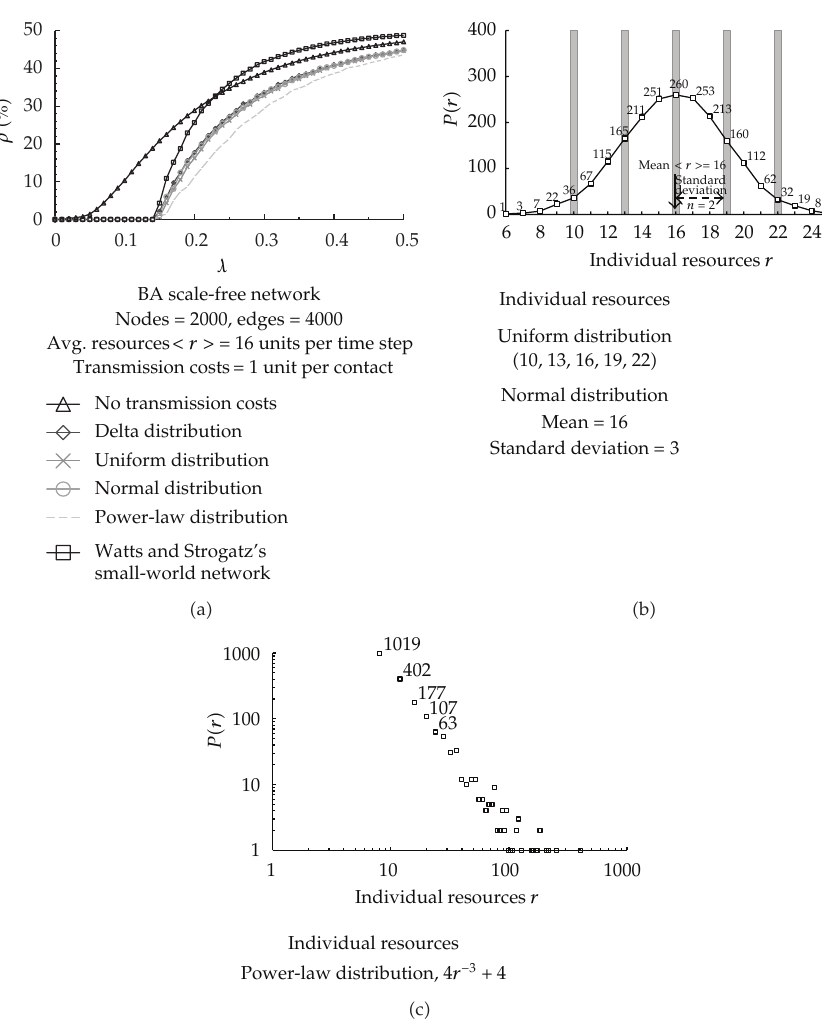
Figure 7: Simulation results for Scale-free network #3. (cid:3) a (cid:4) E ff ects of di ff erent statistical distribution types for agent resources on the density curves and epidemic tipping points of computer viruses spread within scale-free networks. (cid:3) b (cid:4) Uniform (cid:3) n (cid:7) 5, r (cid:7) 3 (cid:4) and normal (cid:3) standard deviation (cid:7) 3 (cid:4) distributions of individual resources with an average (cid:3) r (cid:4) value of 16. (cid:3) c (cid:4) Power-law distribution (cid:3) degree (cid:7) 3 (cid:4) of agent